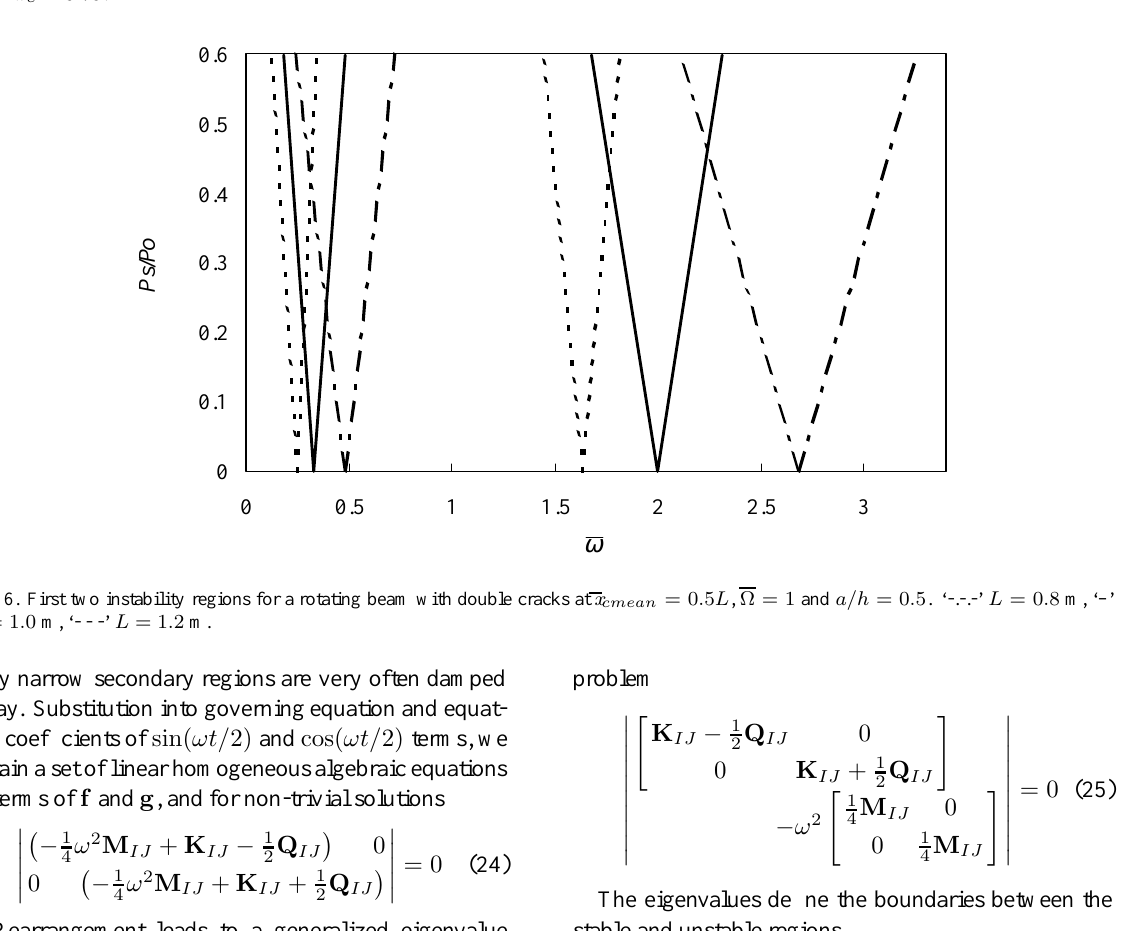
Fig. 5. First two instability regions for a rotating beam with a single crack, L = 1 . 0 m, Ω = 1 and a/h = 0 . 5 . ‘-.-.-’ x c = 0 . 25 , ‘–’ x c = 0 . 5 , ‘- - -’ x c = 0 . 75 .